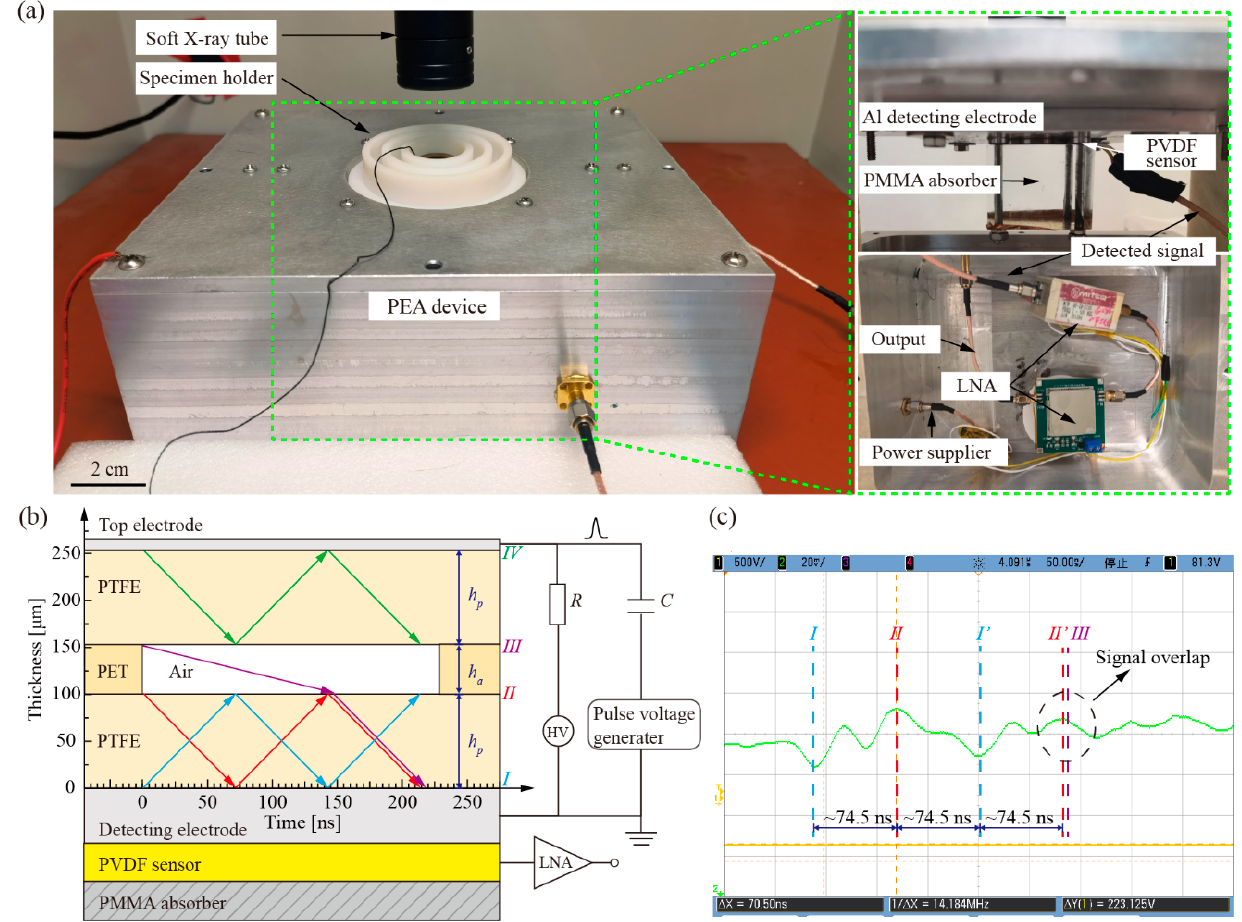
Figure 3. In situ PEA measurement of the space charge for X-ray irradiated cellular electret. ( a ) Experimental setup of PEA system. ( b ) Calculated acoustic waves transmission in the prepared cellular PTFE electret. ( c ) Electrical response signal received by a PVDF